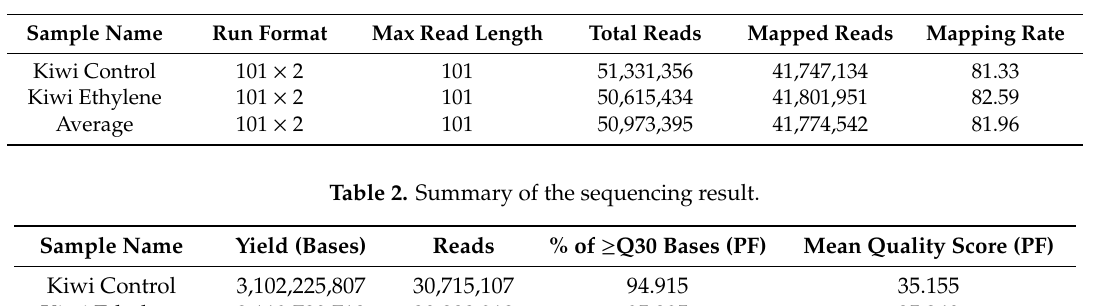
Table 2. Summary of the sequencing result.